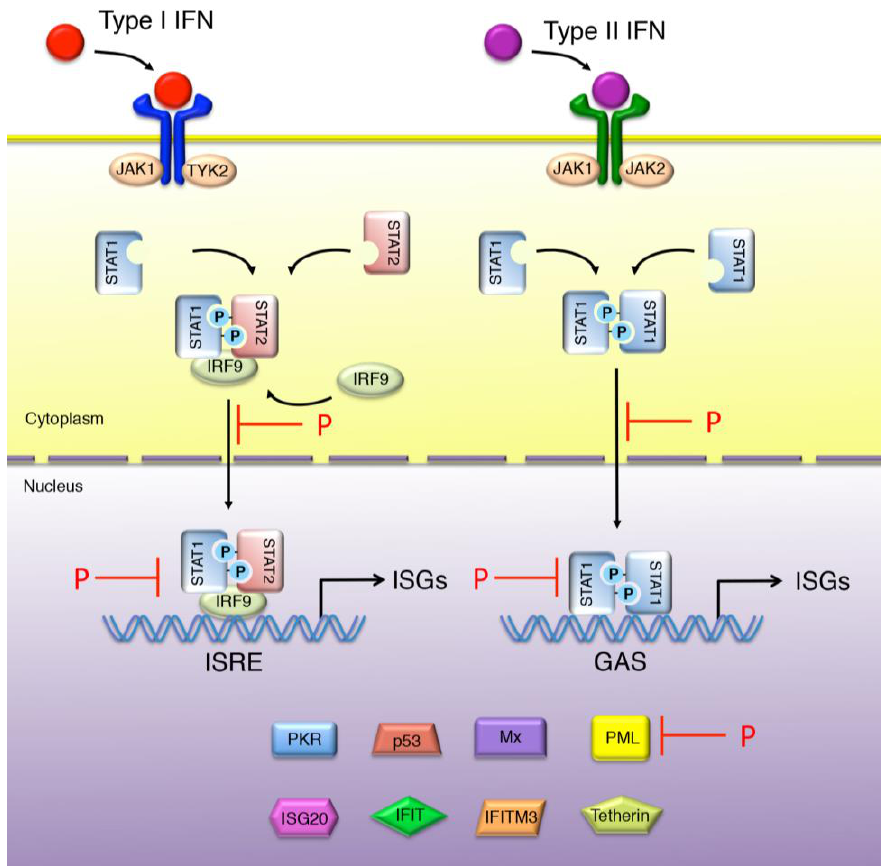
Figure 3. Inhibition of IFN signaling by RABV-P. The interaction of Type I IFN with IFNAR leads to the activation of the JAK tyrosine kinases (Tyk2 and JAK1) resulting in the phosphorylation of STAT1 and STAT2, which form, with IRF9, the complex ISGF3. ISGF3 translocates to the nucleus and induces the expression of ISGs that harbor an ISRE. The binding of Type II IFN to its receptor, IFNGR, results in the phosphorylation of STAT1 by JAK1 and JAK2. pSTAT1 homodimers migrate to the nucleus and bind to the GAS in the promoter region of specific ISGs. The steps counteracted by the RABV-P are indicated: P interacts with STAT1 and STAT2, and thereby blocks IFN signaling by STAT1 sequestration in the cytoplasm and the inhibition of pSTAT1 and ISGF3 binding to DNA promoters.